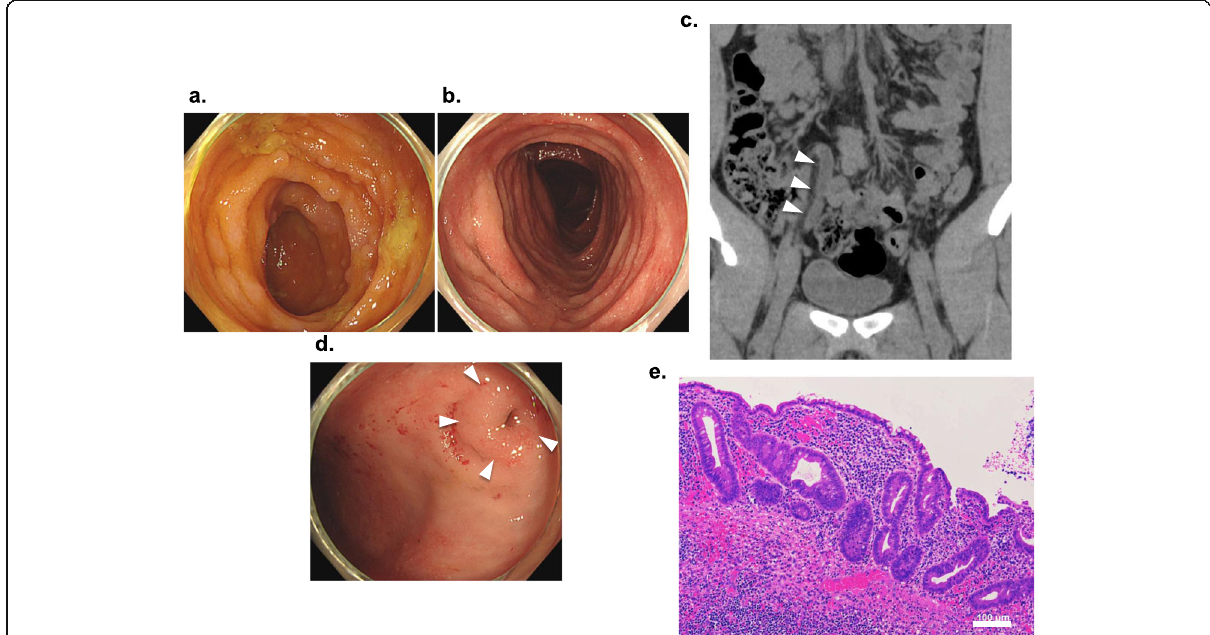
Fig. 2 a , b Colonoscopic findings: continuous ulcerative lesions and erythema were observed. c CT fingings: CT revealed a swollen appendix on every symptomatic course (arrow heads). d Colonoscopic findings: The appendiceal orifice was almost normal (arrow heads). e Pathological examination: the pathological finding revealed inflammatory cells infiltration and crypt distortion in the resected